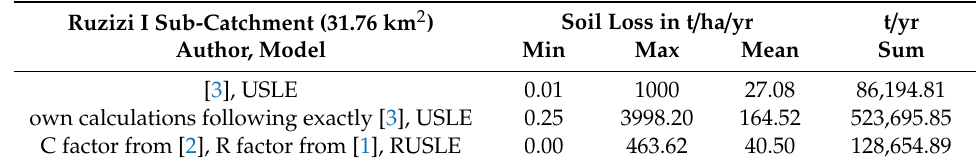
Table 7. (R)USLE results for sub-catchment Ruzizi I.